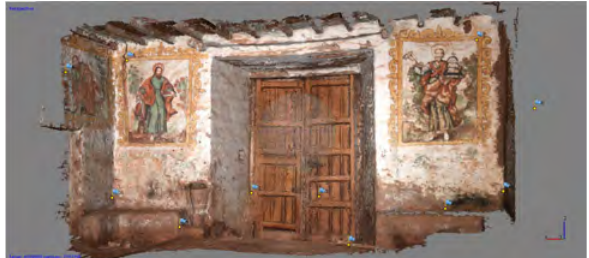
Figure 5. Final photogrammetric model of the east entrance with scaled survey points picked (blue flags) and texture applied